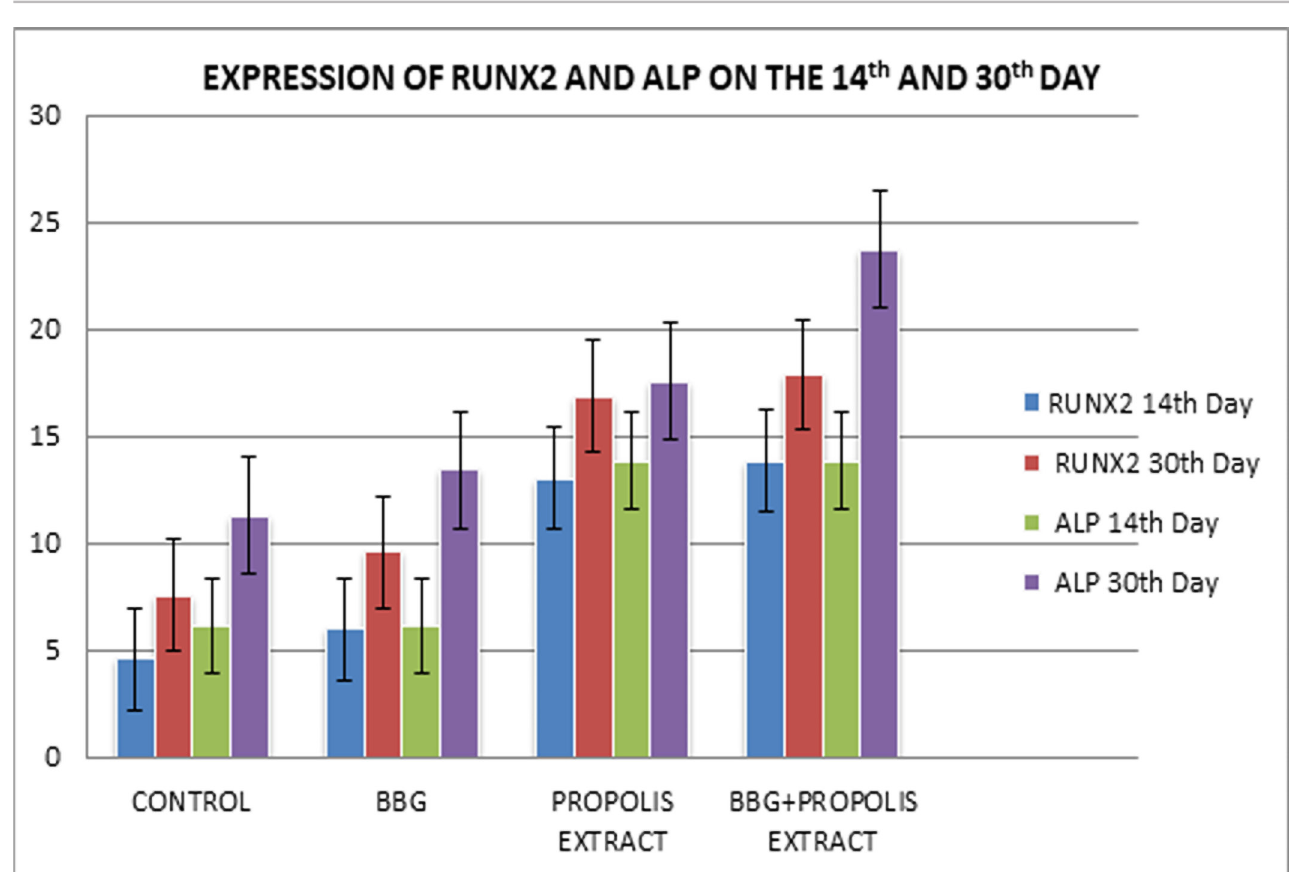
FIGURE 1 - RUNX2 and ALP expressions in each group on the 14th and 30th